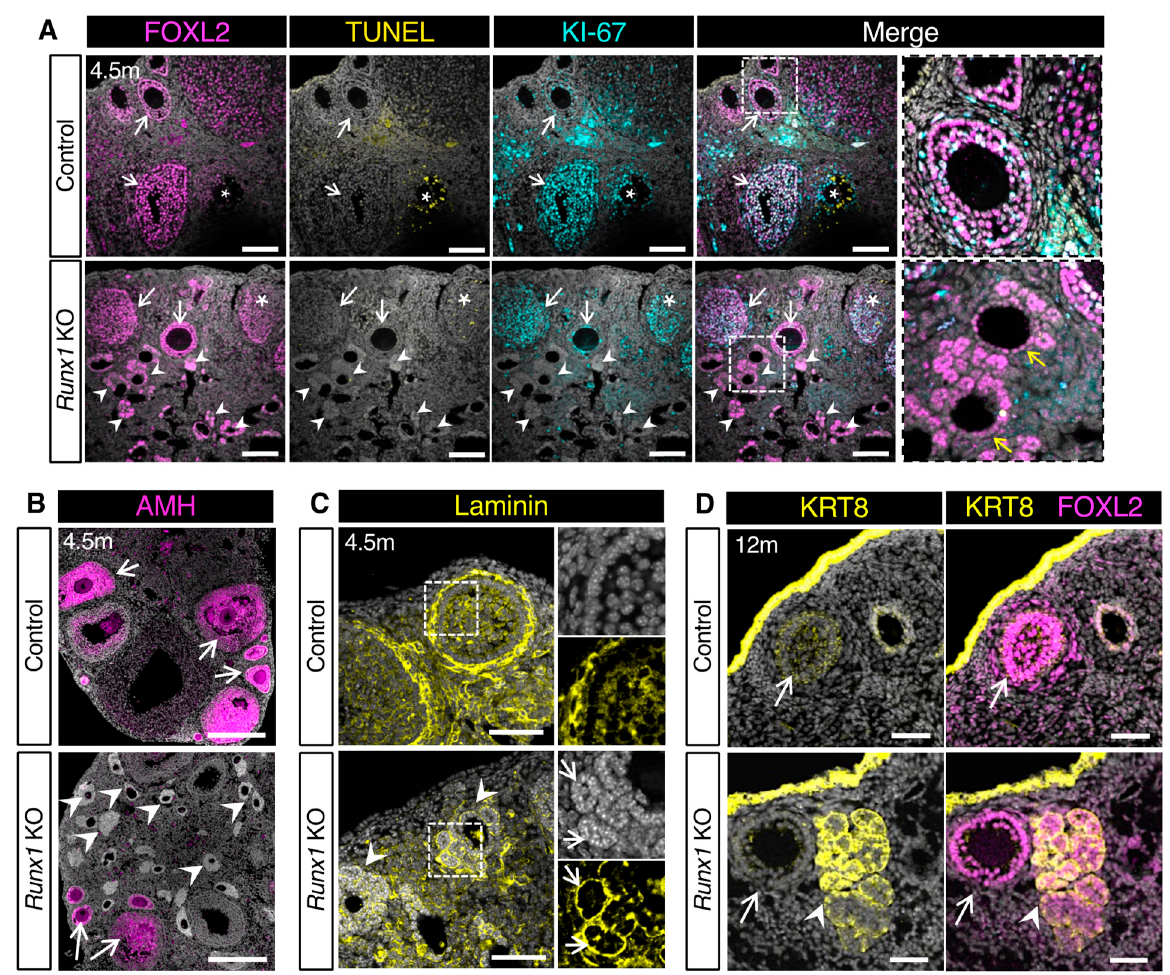
Figure 4. Characterization of the follicle-like lesions in Runx1 knockout mice. ( A ) Immunofluores- cence for granulosa cell marker FOXL2 (magenta), proliferation marker KI-67 (cyan), and TUNEL cell death labeling (yellow) in control and Runx1 KO ovaries at 4.5 months. The grey color represents DAPI nuclear counterstaining. Right panels are higher magnifications of outlined areas. Arrows point to normal follicles; arrowheads point to abnormal follicles; asterisks indicate atretic follicles with TUNEL+ dying cells; yellow arrows indicate the asymmetric organization of follicle-like lesions with one layer of FOXL2 granulosa cells. Scale bars: 250 μ m. ( B ) Immunofluorescence for granulosa cell marker AMH (magenta) with DAPI (grey) in 4.5-month control and Runx1 KO ovaries. Scale bar: 250 μ m. ( C ) Immunofluorescence for basal membrane protein laminin (yellow) with DAPI (grey) in 4.5-month control and Runx1 KO ovaries. Right panels are single-channel outlined areas with higher magnifications. Arrowheads point to follicle-like lesions; arrows point to rosette-like structures surrounded by laminin within the lesions; scale bar: 50 μ m. ( D ) Immunofluorescence for granulosa cell marker FOXL2 (magenta) and epithelial marker KRT8 (yellow) in 12-month control and Runx1 KO ovaries. Arrows point to normal follicles; arrowheads point to follicle-like lesions. Scale bar: 100 μ m; n = 4/genotype for all immunofluorescences.